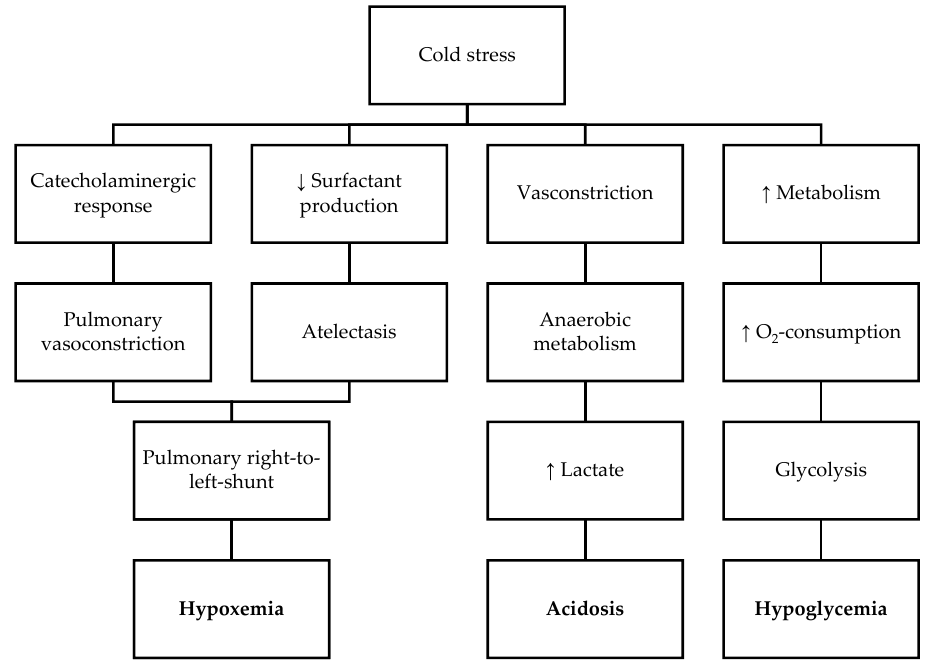
Figure 1. Pathophysiological pathways resulting from adverse events induced by cold stress in neonates. In very low birth weight (VLBW) infants (<1500 g), transient neonatal hypothermia after birth is associated with intraventricular haemorrhage and death [54].